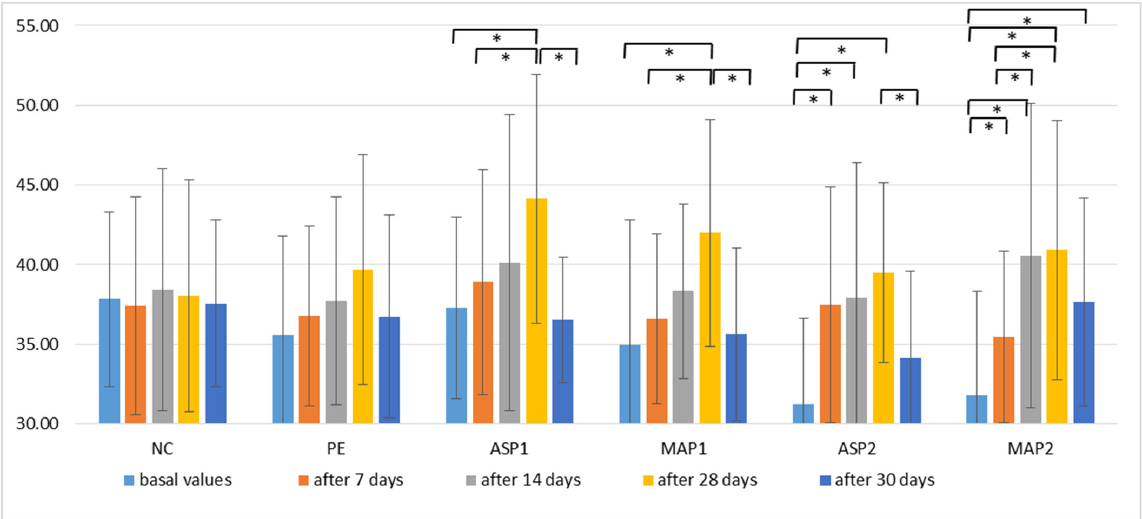
Figure 4. In vivo determined mean values with a standard deviation of electrical capacitance (EC) for non-treated control (NC), placebo emulgel (PE) and investigated emulgels (ASP1, MAP1, ASP2 and MAP2) after 7, 14, and 28 days of application, and 2 days after the cessation of application. Significant differences are marked with * ( p < 0.05).